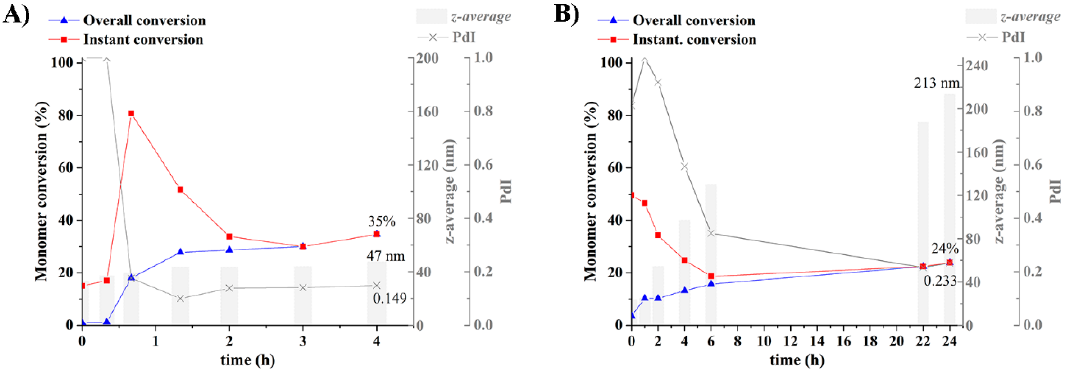
Figure 2. Monomer conversion (gravimetric analysis) and hydrodynamic diameter ( z -average, dynamic light scattering (DLS) measurements) of aliquots withdrawn during the copolymerization of MMA:BA (10:1 w/w ) in the presence of P(PEGA 40 )-TTC using the initiator VA-044 at ( A ) 70 °C and at ( B ) 44 °C. BA: butyl acrylate, MMA: methyl methacrylate.